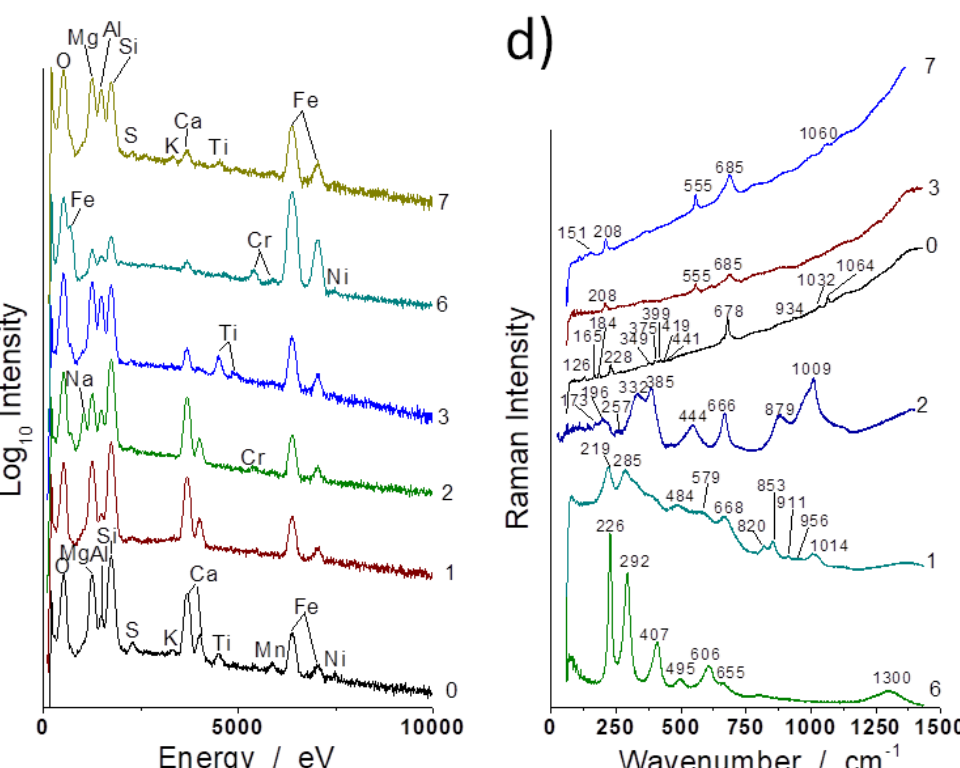
Figure A4. Representative EDS (left ) and Raman ( right ) spectra recorded on some spots of sample d (see Figure 1).